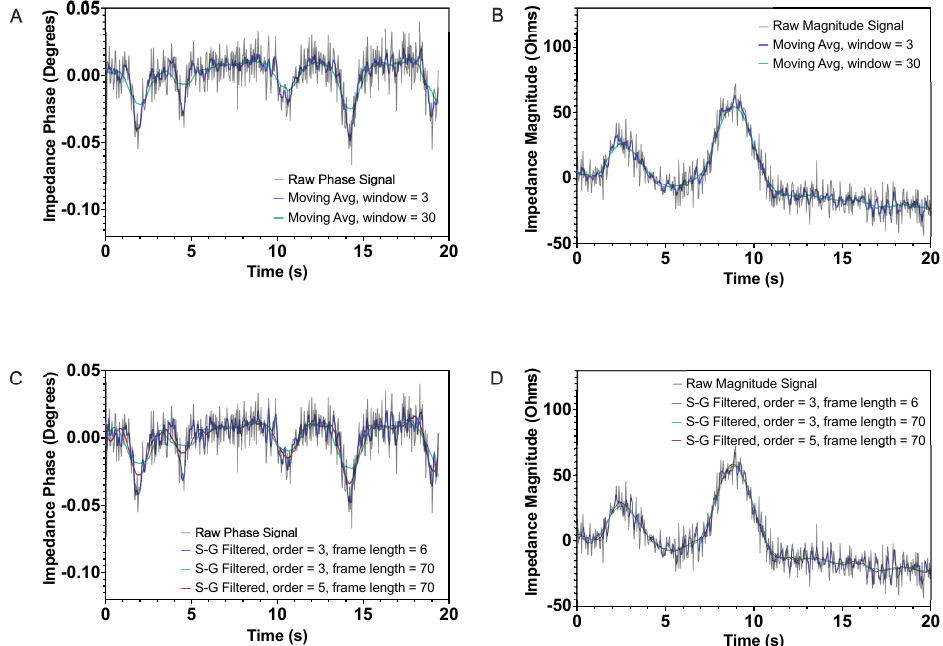
Figure 7. Signal detection algorithm output plotted against detrended noisy impedance output profiles corresponding to ( A ) impedance magnitude of live cells, ( B ) impedance magnitude of dead cells, ( C ) impedance phase of live cells, and ( D ) impedance phase of dead cells. At 2 MHz, cell viability status can easily be discriminated by identifying detection events in impedance magnitude and phase profiles. Live cells clearly display impedance phase changes with no discernible impedance magnitude change, whereas dead